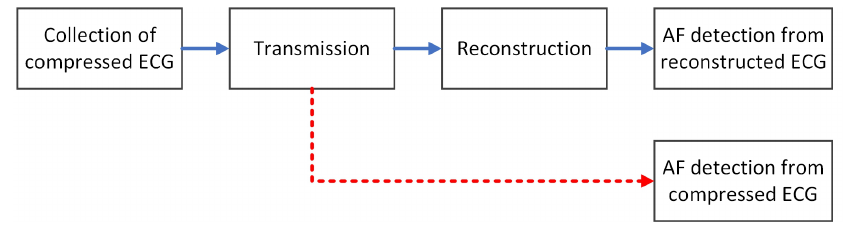
Figure 2. AF Detection based on compressed